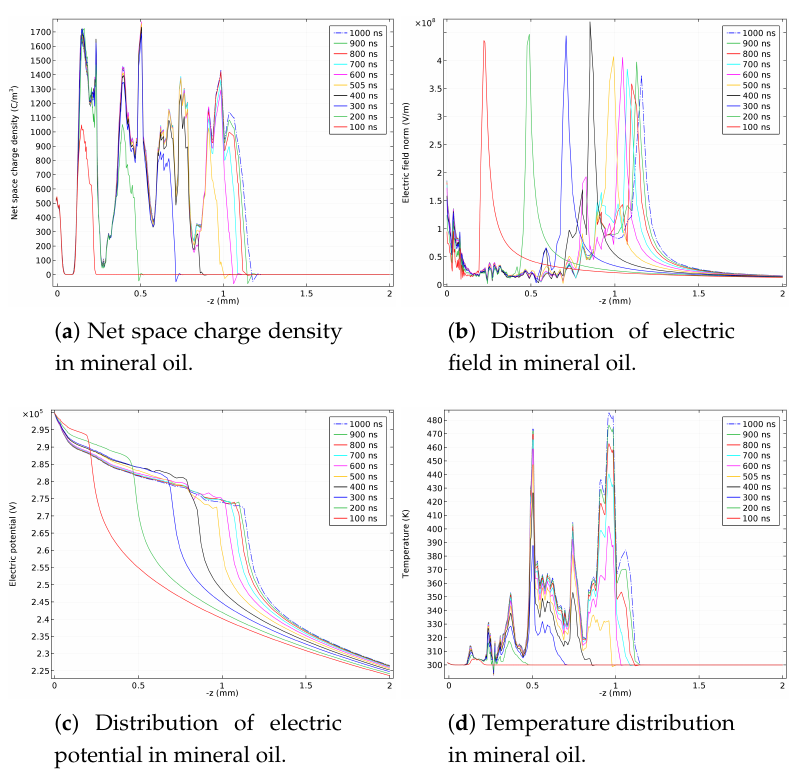
Figure 4. ( a ) Net space charge density, ( b ) distribution of electric field, ( c ) distribution of electric potential, and ( d ) temperature distribution along the z -axis from t = 0 to 1000 ns in intervals of 100 ns from the simulations in mineral transformer